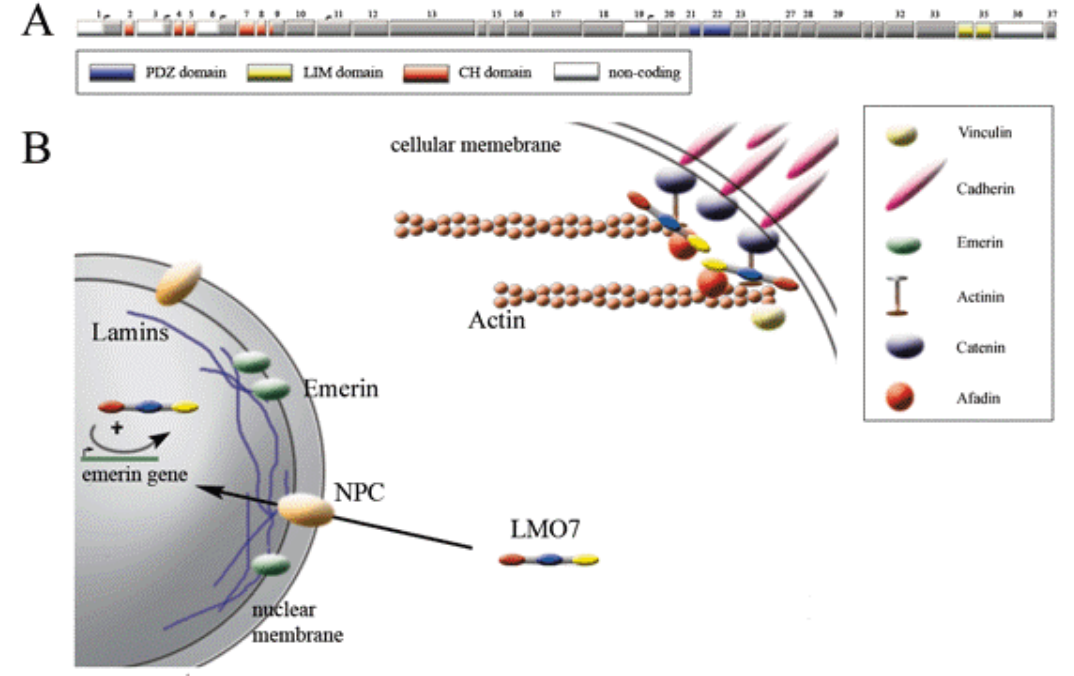
FIGURE 4 . The gene architecture and molecular interactions of LIM domain only 7. (A) Depicted is the LMO7 gene structure as based on the Ensembl data (ENSG00000136153). In red, the exons encoding the CH domain are indicated. The exons shaded blue and yellow harbor the genetic information for both the PDZ and LIM domain, respectively. The gene structure shown also displays several alternative transcription initiation sites. (B) Shown is a summary of the interactions known to involve the LMO7 protein. Upon translocation to the nucleus, LMO7 is able to up-regulate emerin expression. Additionally, several other muscle-specific proteins may become regulated via a similar